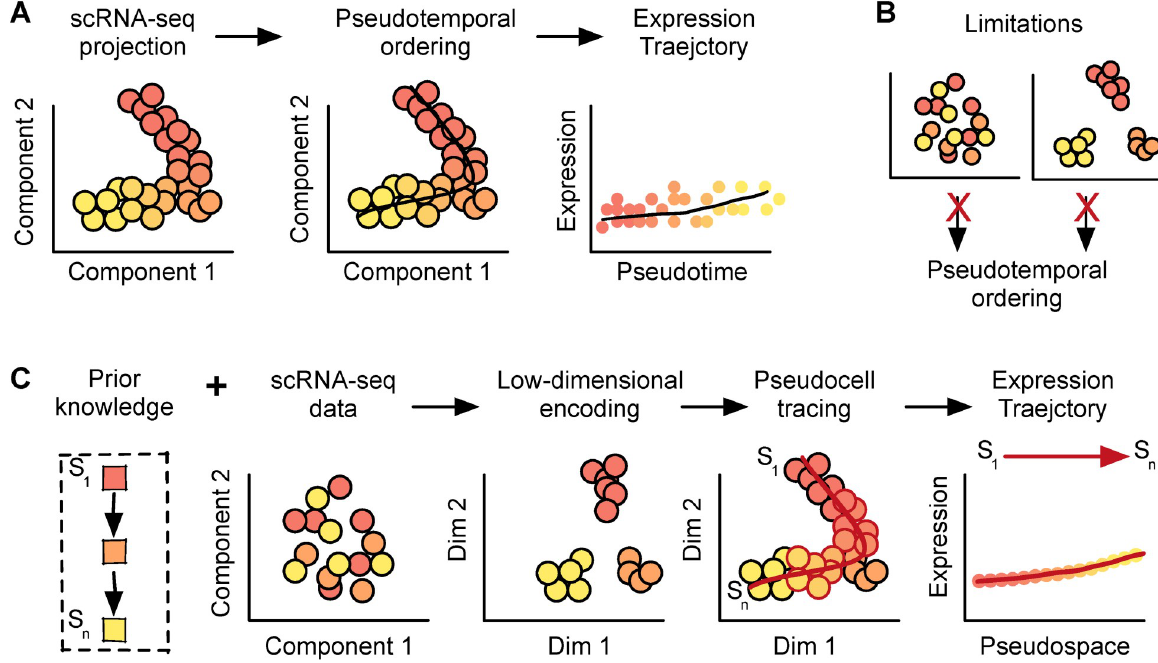
Fig 1. Pseudocell Tracer, a framework for modeling cellular trajectories in complex systems. (A) An overview of pseudotime trajectory inference. (B) Some scenarios that may obstruct pseudotime ordering. (C) Pseudocell Tracer. Given some prior knowledge about a model system, we aim to predict expression trajectories by generating pesudocells at regular intervals along a virtual cell-state axis, even though such cells may be sparsely captured in single cell profiling data.